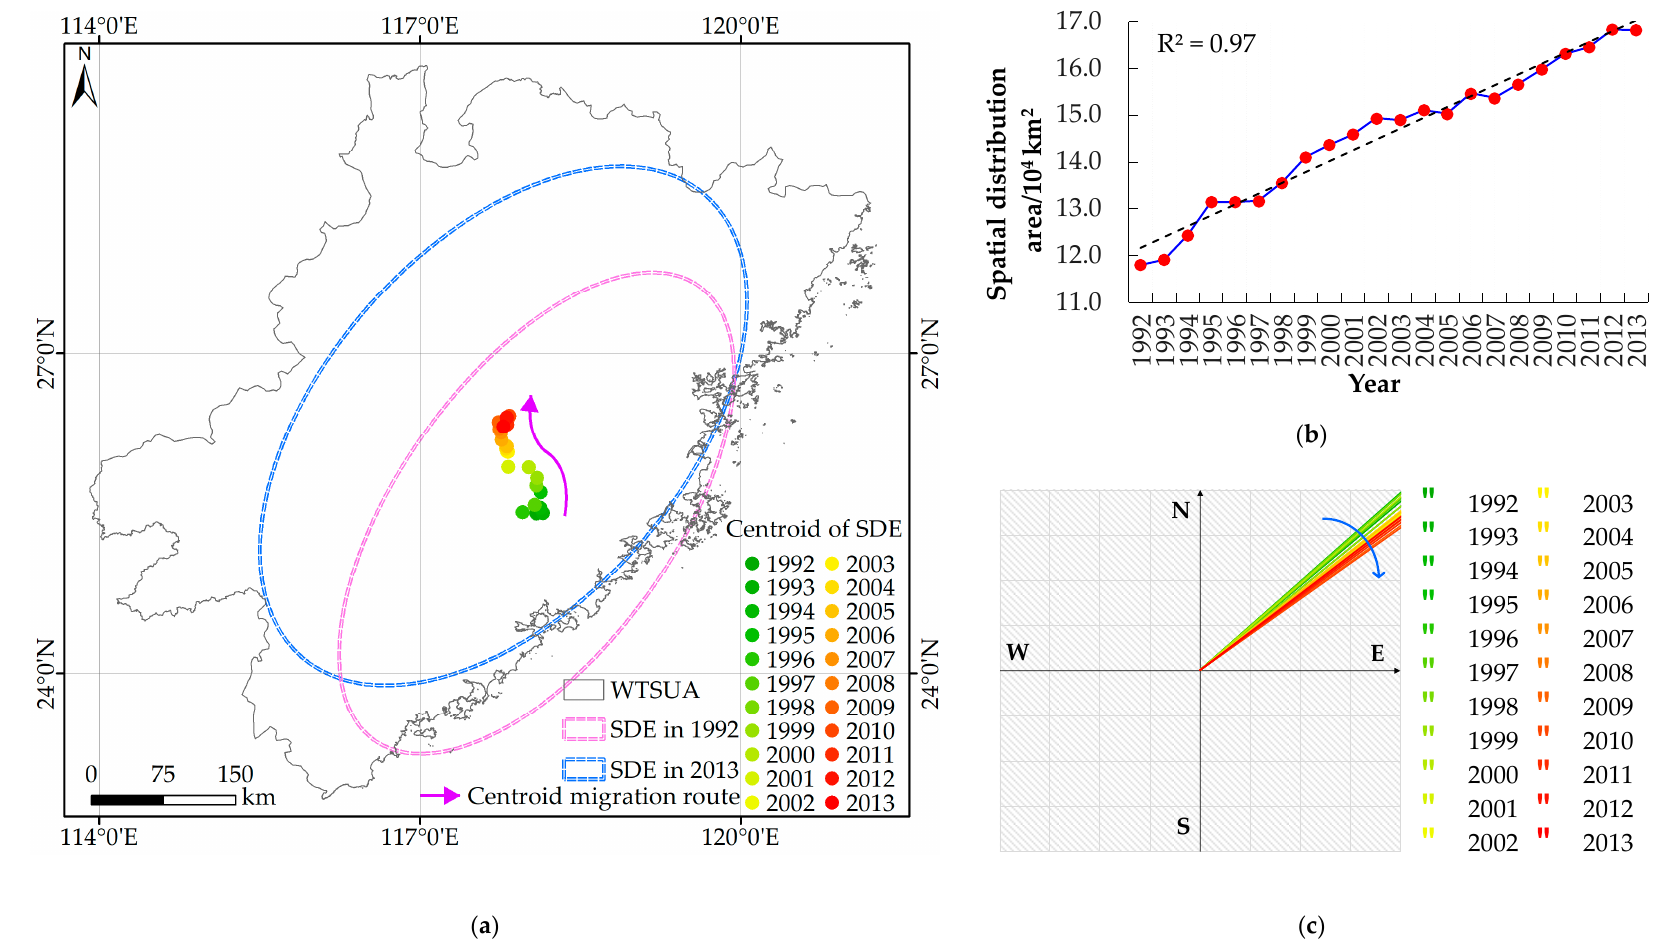
Figure 3. Spatio-temporal dynamics of standard deviation ellipse (SDE) elements for urban areas from 1992 to 2013. ( a ) spatial distribution and centroid migration route of SDE from 1992 to 2013; ( b ) areal change trend of SDE spatial distribution from 1992 to 2013; ( c ) azimuth change of SDE from 1992 to 2013.